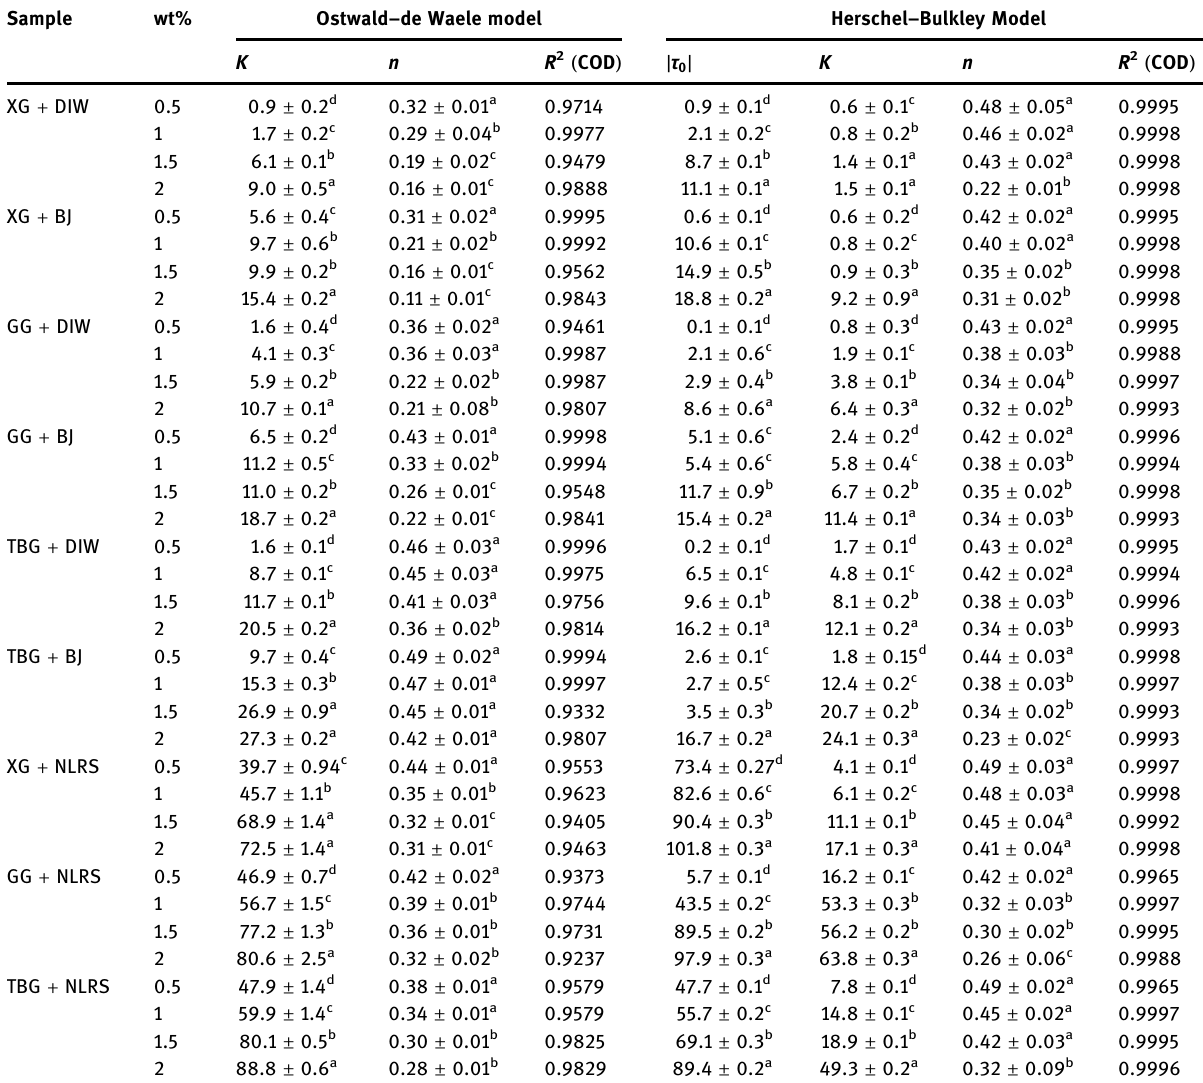
Table 3: Model parameters for shear viscosity – shear rate regression fi tting Sample wt% Ostwald – de Waele model Herschel – Bulkley